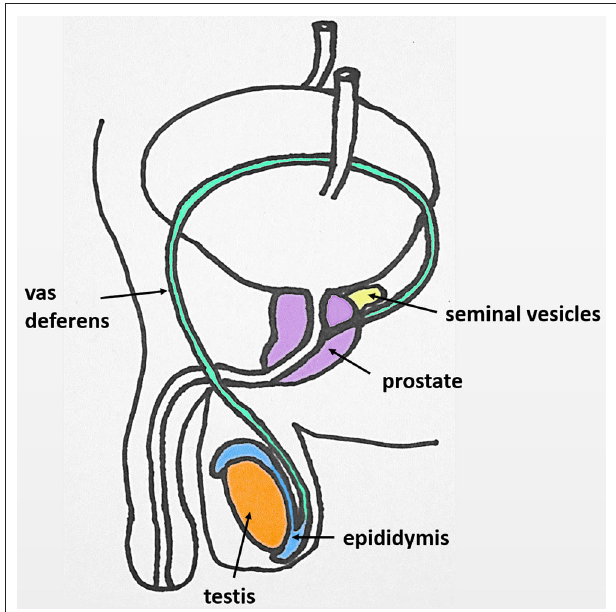
FIGURE 1 | Original: Anatomy of the human male reproductive tract.